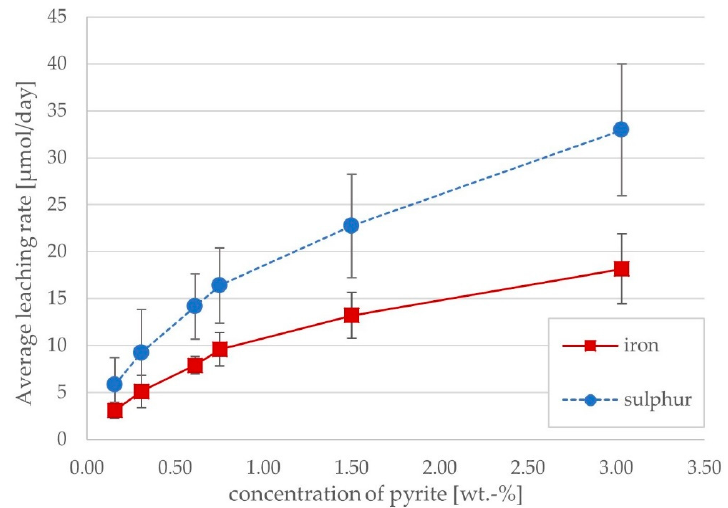
Figure 4. Average leaching rates of iron and sulphur correlate with the content of pyrite in the columns, with standard deviation as error bars.